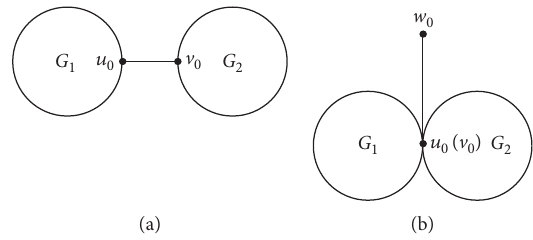
Figure 1: The edge-lifting transformation. (a) G . (b) G ′